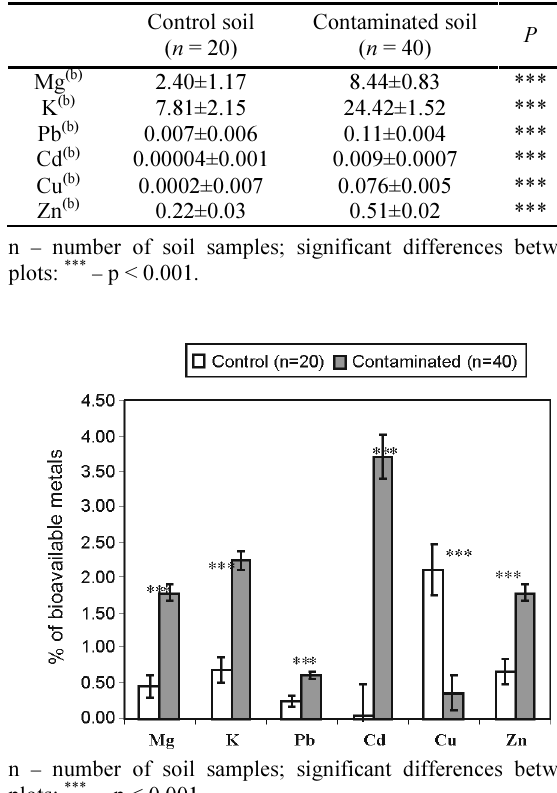
Fig. 4. Bioavailable metals in control and contaminated soils, %. Values are means±SD (vertical lines) Percentage of bioavailable Pb, Cd, Zn, K and Mg (except Cu) on the contaminated plot was significantly higher ( p < 0.001) than on the control plot. In neutral soil reaction (pH 7.0) bioavailability of Cu is very low (Maž- vila 2001), as a result the contaminated plot pH